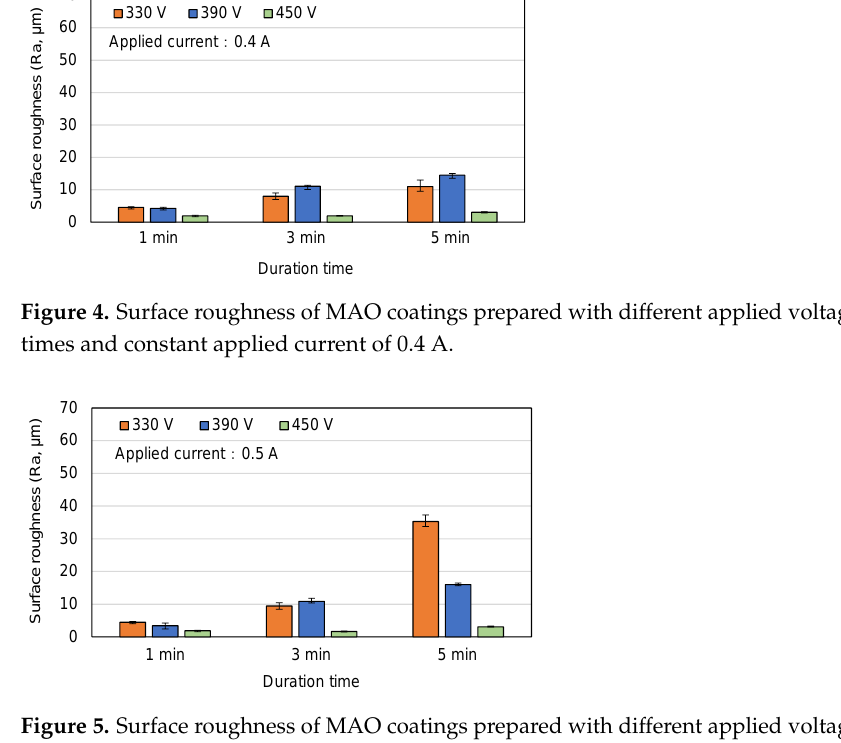
Figure 5. Surface roughness of MAO coatings prepared with different applied voltages and duration times and constant applied current of 0.5 A.